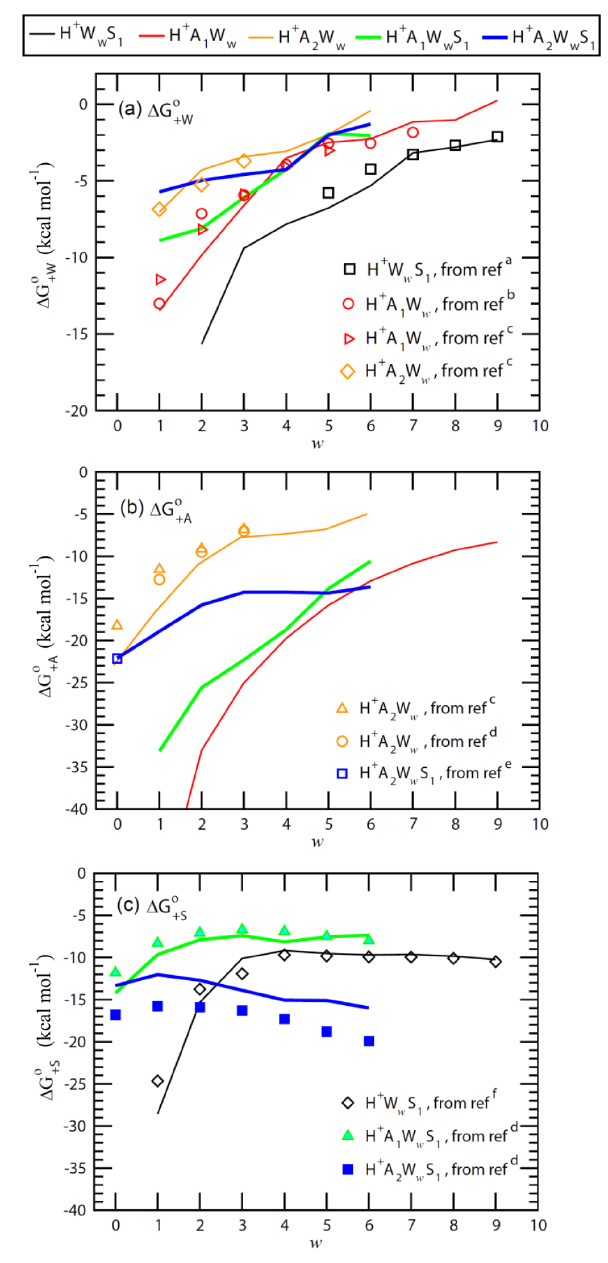
Figure 2. Stepwise Gibbs free energy change under standard con- ), or ditions for the addition of a water ( (cid:49)G o + ), ammonia ( (cid:49)G o + W A ) molecule to form the given positively charged sulfuric acid ( (cid:49)G o + S clusters as a function of the number of water molecules in the clus- ters ( w ). Lines are QC-based values, and symbols are experimental results or semi-experimental estimates (see notes under Table A2 for the